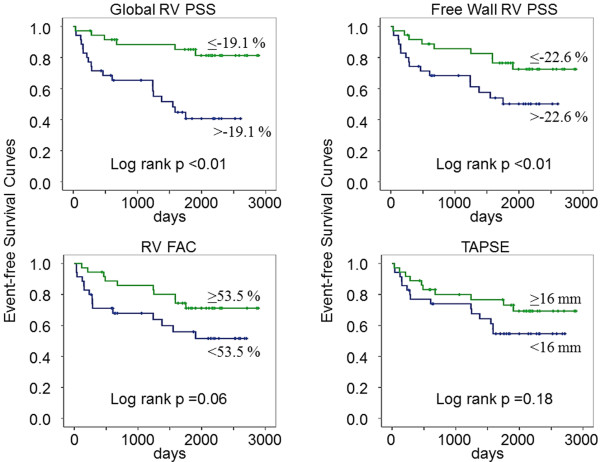
Kaplan–Meier event-free survival curves for the composite endpoint of heart failure hospitalization and cardiovascular death. Patients are stratified by global RV PSS (left top), free wall RV PSS (right top), RV FAC (left bottom), and TAPSE (right bottom).